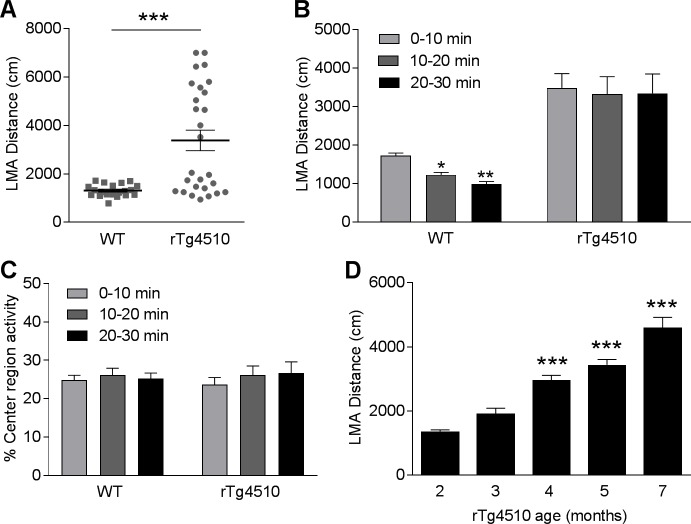
rTg4510 mice exhibit increased LMA in an age-dependent manner.(A) Averaged travel distance during a 30 min LMA test revealed increased LMA in 5-month-old rTg4510 mice compared to the WT littermates. (***p<0.001, t-test, n = 20 WT and 27 rTg4510 mice). (B) Time course distance traveled in 10-min bins. (* p<0.05, **p<0.01 compared to the first time bin, two-way ANOVA followed by Bonferroni post hoc test, n = 20 WT and 27 rTg4510 mice). (C) Five-month-old rTg4510 mice displayed similar percentage of center region activity as the WT littermates. (D) rTg4510 mice exhibited age-dependent increase in LMA. (***p<0.001 compared to 2-month-old rTg4510 mice, one-way ANOVA followed by Bonferroni post hoc test; n = 120, 124, 229, 190, and 36 per group for rTg4510 mice at 2, 3, 4, 5, 7 months of age, respectively).